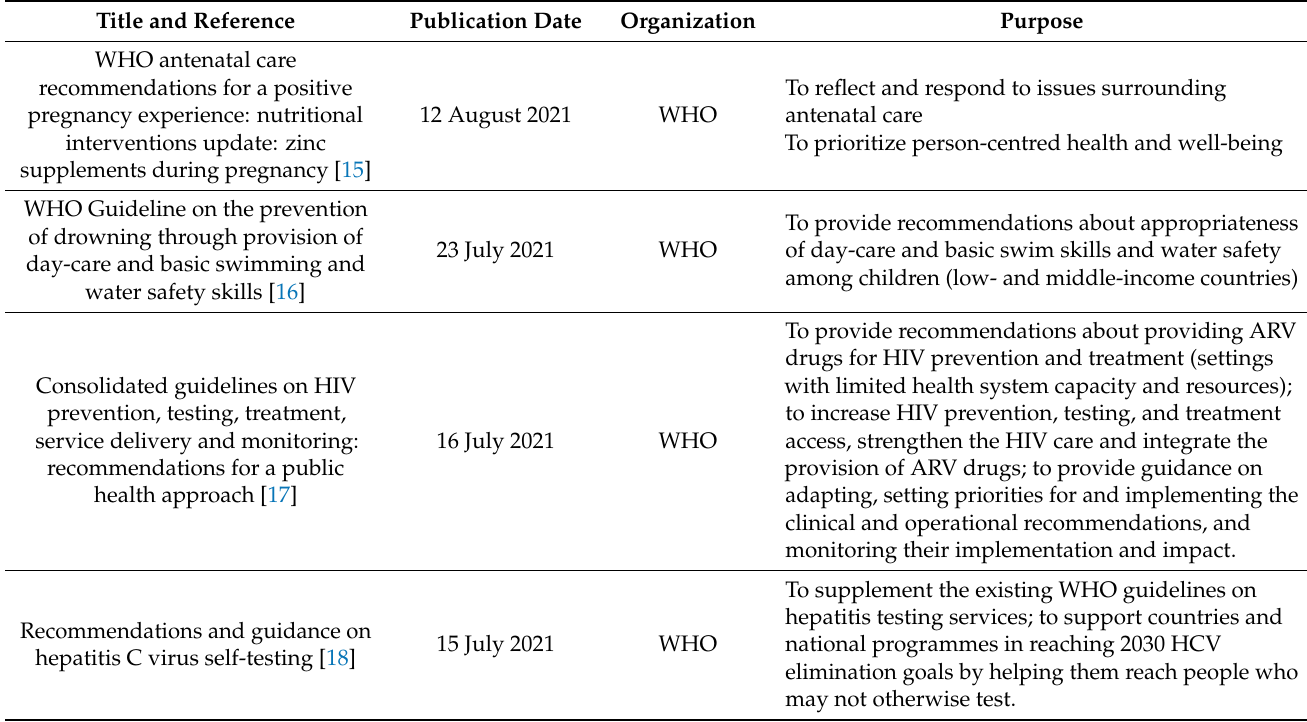
Table 1. A list of identified guidelines and their basic